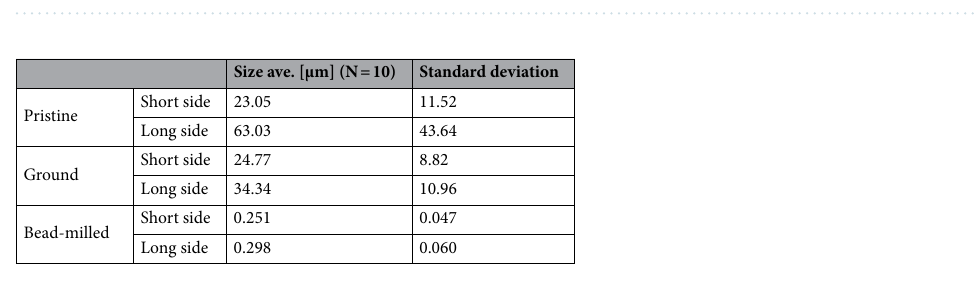
Figure 3. SEM images of ( a ) pristine, ( c ) ground, and ( e ) bead-milled FA. Graphs of the long axis versus the short axis of 10 particles for ( b ) pristine, ( d ) ground, and ( f ) bead-milled FA.